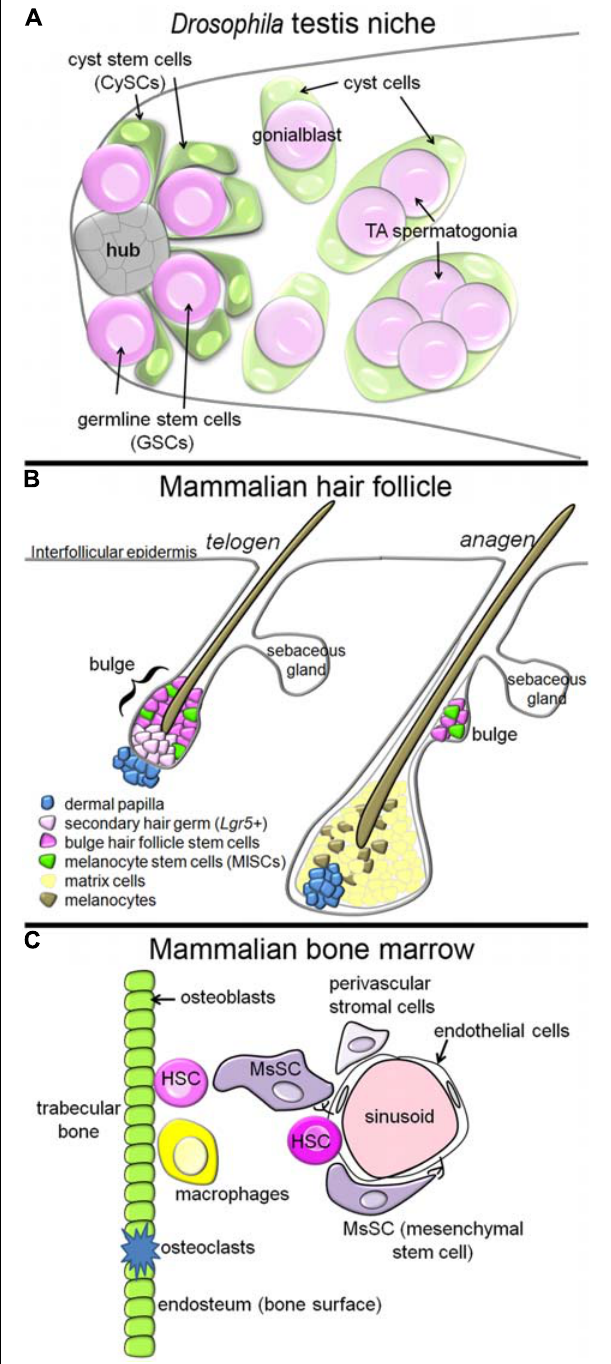
FIGURE 1 |Tissue architecture of three stem cell niches. (A) In the Drosophila testis niche, two stem cell populations, the GSCs and CySCs, intermingle around a cluster of cells called the hub.When the stem cell populations divide, daughters that move away from the hub differentiate, and the differentiating germ cells, which begin to undergoTA, become encysted by the differentiating cyst cells. In this niche, the CySCs produce signals promoting the self-renewal of neighboring GSCs. (B) In the mammalian hair follicle, the bulge and sHG HFSCs reside next to